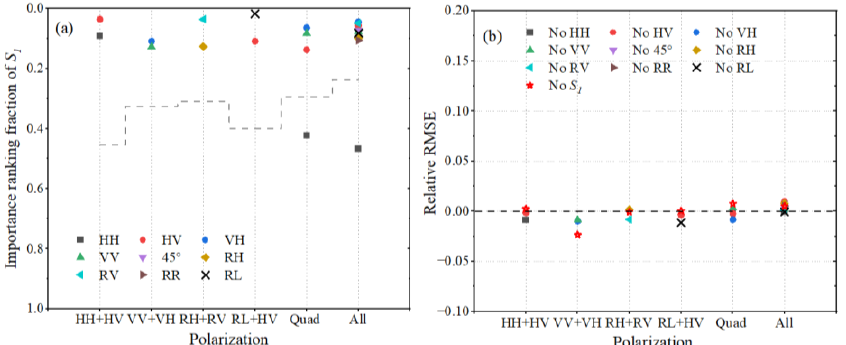
Figure 29. The importance of S 1 to SWH retrieval from combined-polarization models. ( a ) The importance ranking of S 1 provided by XGBoost models, normalized to the range of 0–1. ( b ) The effect of removing S 1 on the SWH estimation from different polarized models. The red pentagrams represent the relative RMSE corresponding to the removal of S 1 -terms in the combined-polarization models.